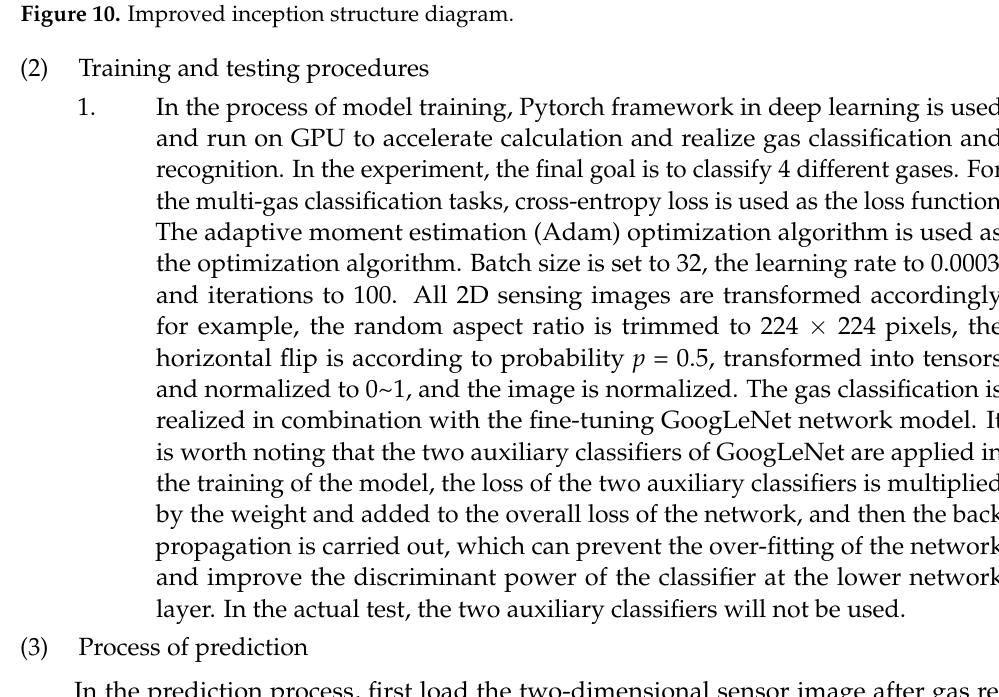
Figure 10. Improved inception structure diagram.